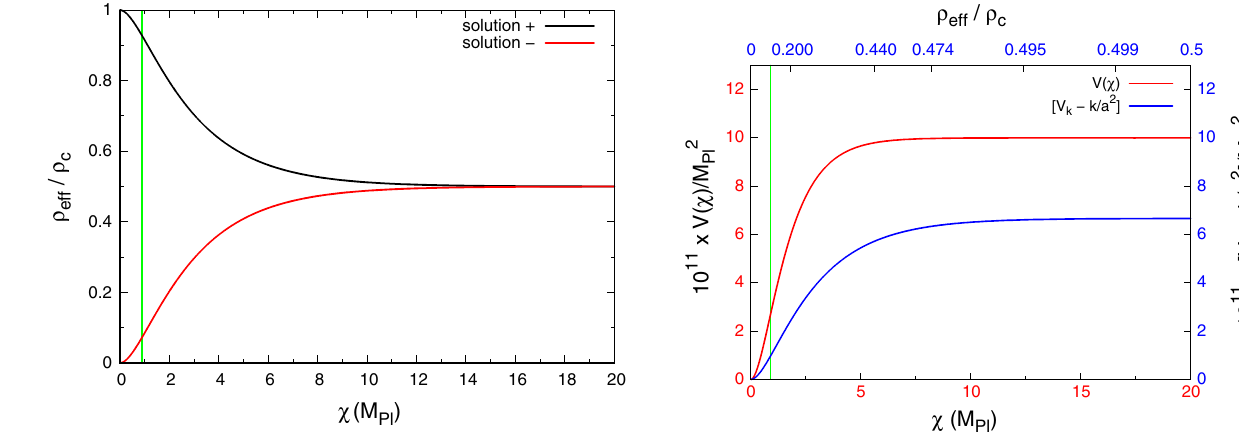
Fig. 2 The evolution of HI potential and MG curvature potential. The behaviorof V k (ϕ) − ka − 2 mimicsthesamedynamics,representedbythe evolution of the Hubble parameter, as that obtained by the HI scenario. The evolution of potential V (χ) as a function of the field χ is presented in the y 1 x 1 axes (in red). The axes y 2 x 2 (in blue) show the evolution of V k (ϕ) − ka − 2 as a function of ρ eff /ρ c . The vertical green line indicates χ (cid:3) 0 . 94 M Pl which represents the end of the inflationary era within end the HI approach (see, for example, [41,43]). See that χ end (cid:3) 0 . 94 M Pl corresponds to ρ eff /ρ c ≈ 0 . 072, value that is in agreement with the LQC requirements for the end of inflation (see, for example,